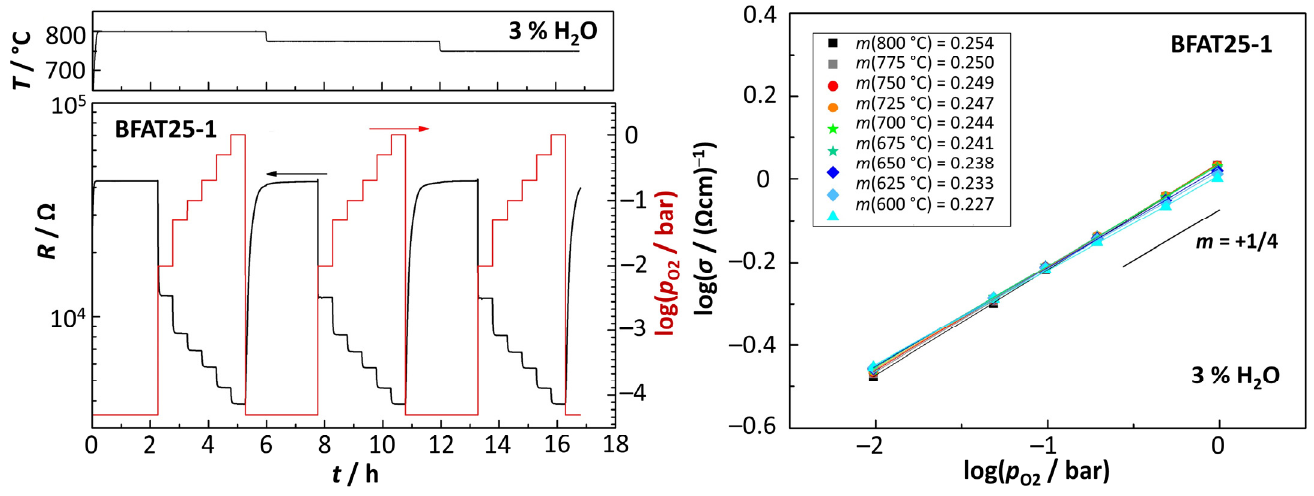
Figure 5. left: electrical resistance of the BFAT25 fi lm at di ff erent p O2 (set points) and temperatures Figure 5. ( left ): electrical resistance of the BFAT25 film at different p O2 (set points) and temperatures (800 °C, 775 °C and 750 °C); right: calculated p O2 -dependencies m . (800 ◦ C, 775 ◦ C and 750 ◦ C); ( right ): calculated p O2 -dependencies m